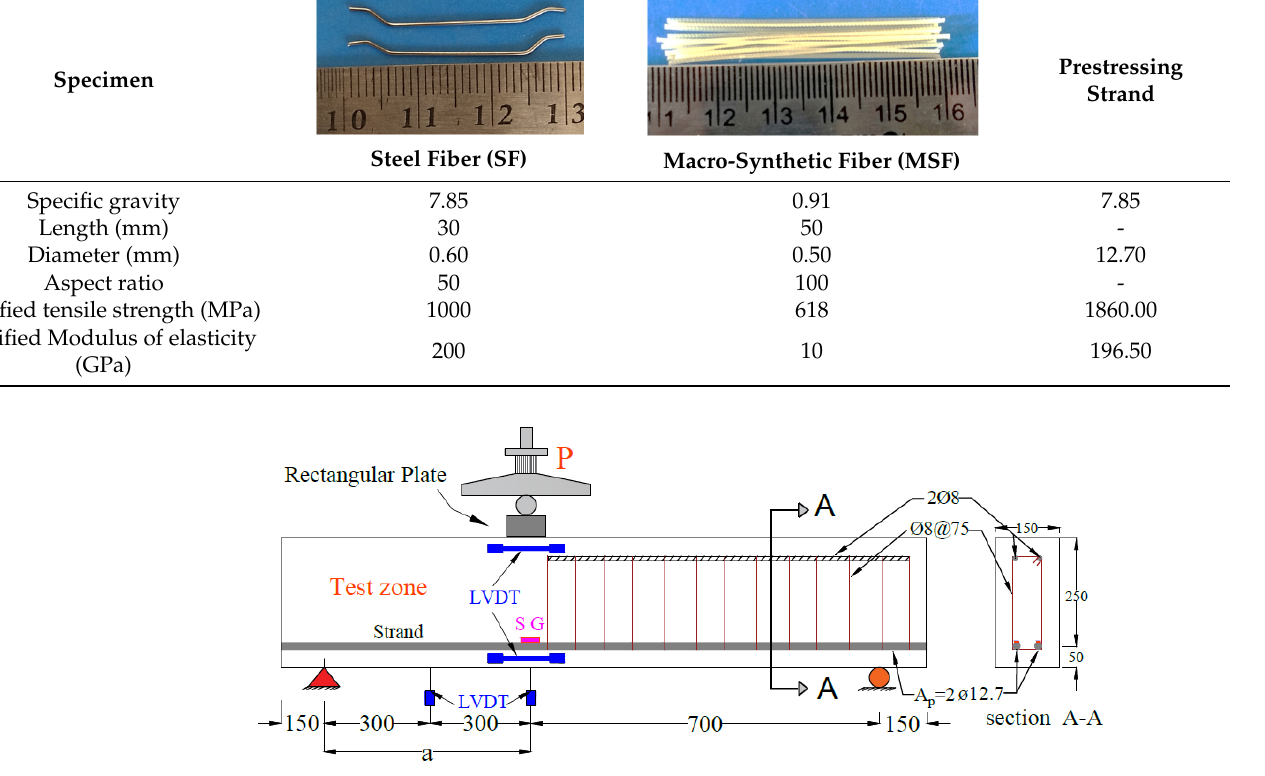
Figure 1. Hybrid fiber reinforced prestressed concrete beam and test setup details. P = applied load, SG = Strain gauge, A-A = cross section view. Table 2. Concrete mix design quantities in kg/m 3 .